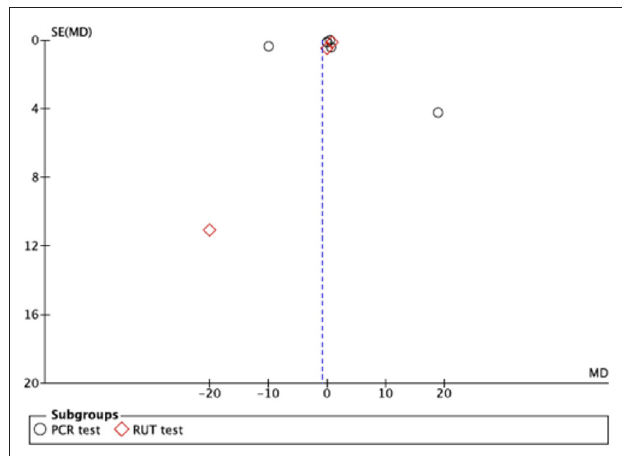
FIGURE 5 | Funnel plot of